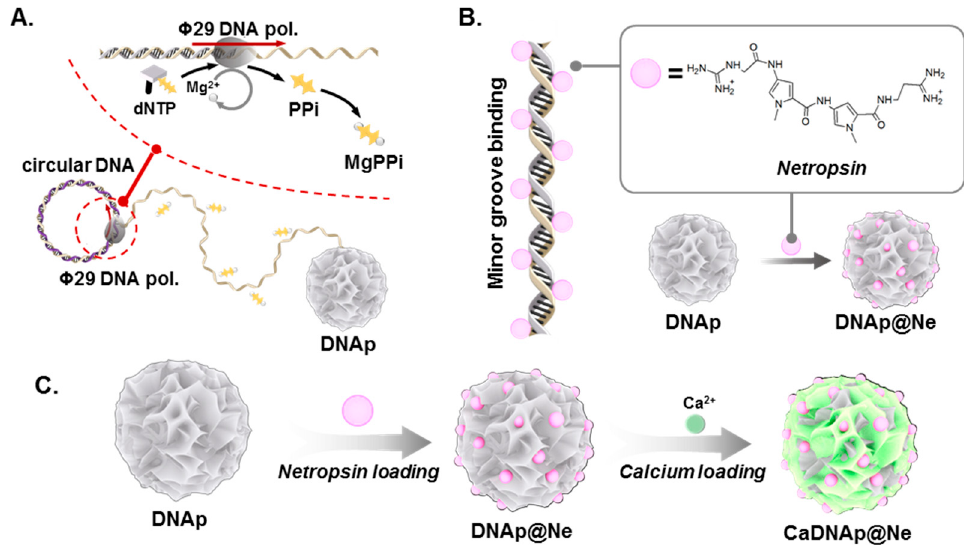
Figure 1. Schematic illustration of CaDNAp@Ne synthesis. ( A ) Scheme for DNA particle (DNAp)